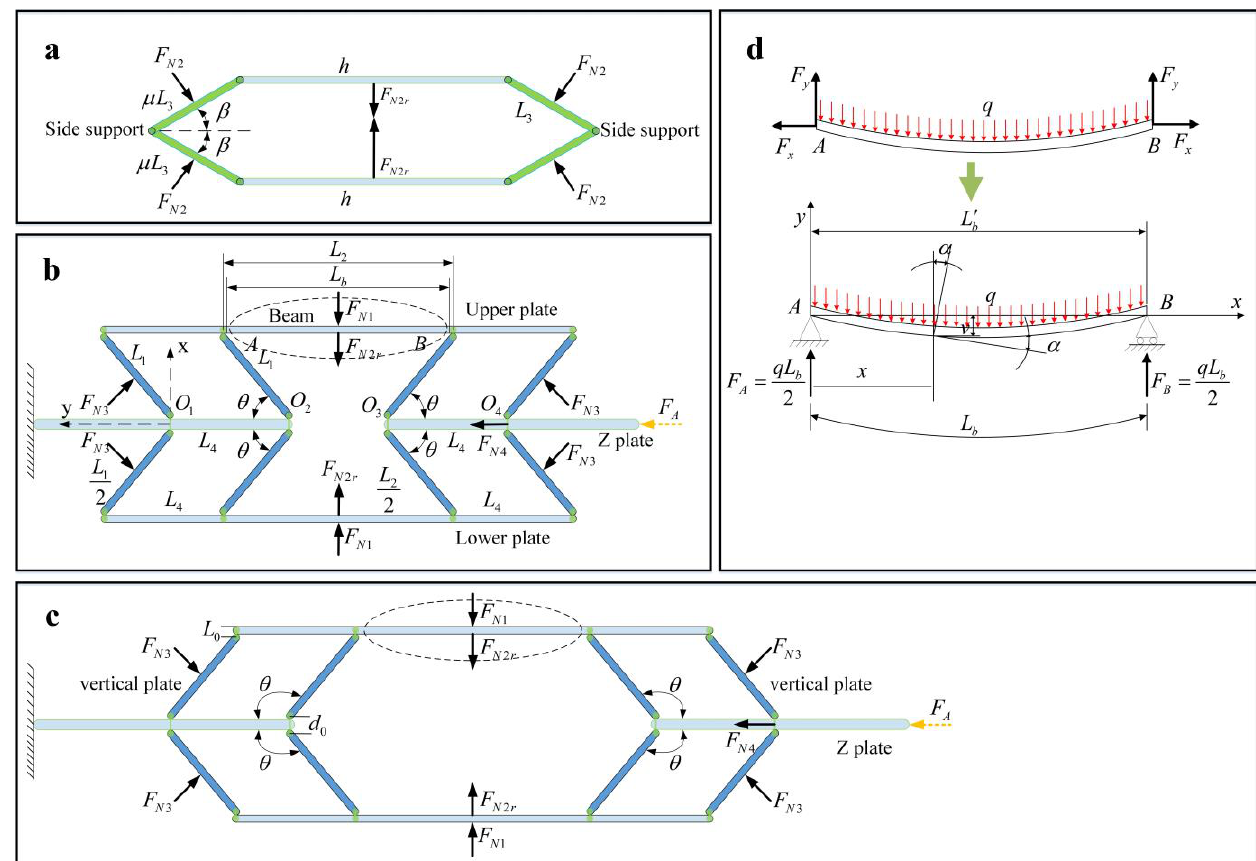
Figure 3. Force analysis of the actuator: ( a ) Force on the side support; ( b ) Force on the mainframe when shrinking; ( c ) Force on the mainframe when stretching; ( d ) Beam deformation analysis.